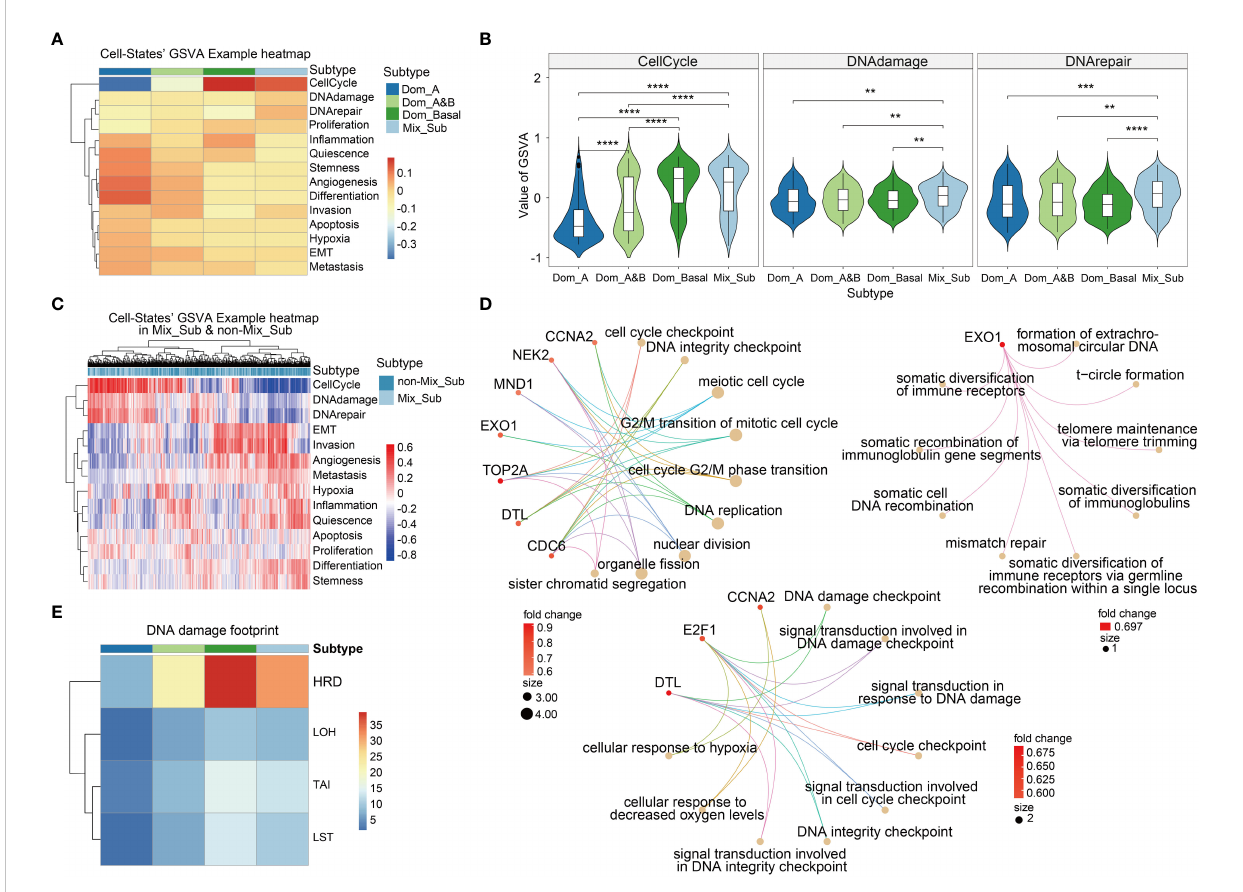
FIGURE 6 (A) The mean values of GSVA enrichment scores of 14 cell states in 4 breast cancer subtypes. (B) GSVA scores in the three speci fi c cell states in 4 breast cancer molecular subtypes (Wilcoxon-test, '**'p < 0.01, '***'p < 0.001, '****'p < 0.0001). (C) GSVA scores of cell states for each patient in Mix_Sub and non-Mix_Sub subtypes. (D) The main biological functions involved the differentially expressed genes of the three speci fi c cell states. Top left: Cell cycle-speci fi c pathways. Middle and lower: DNA damage speci fi c pathways. Upper right: DNA repair speci fi c pathways. (E) DNA damage footprint